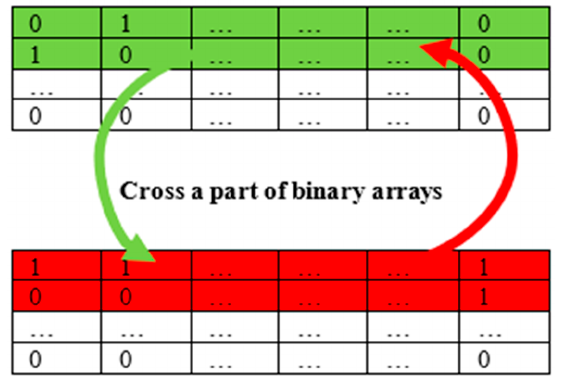
Figure 4. Crossover process.